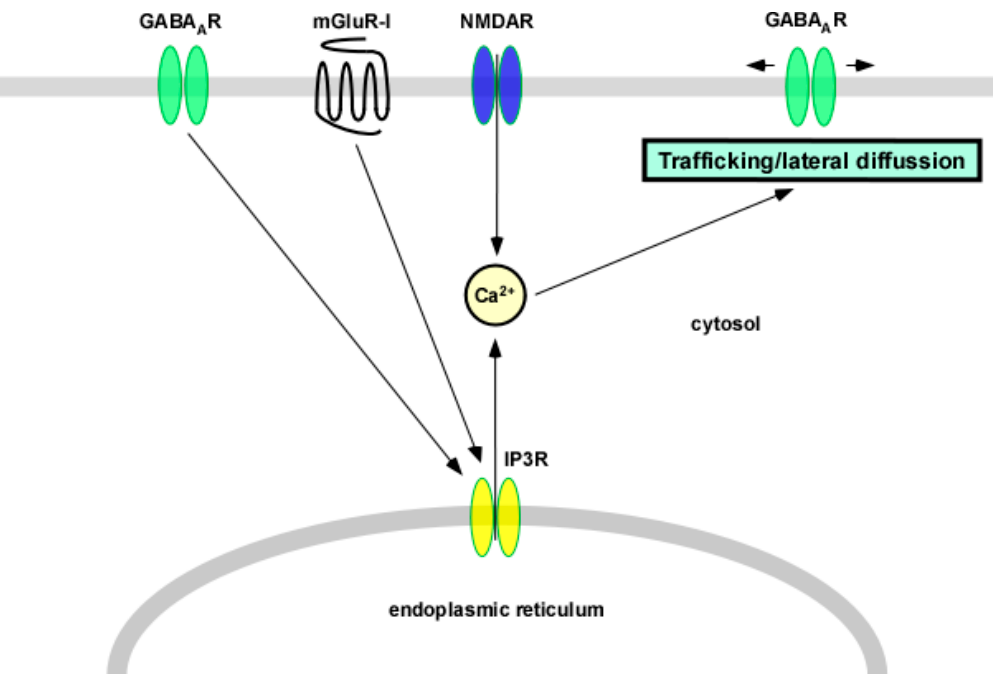
Figure 3. Regulation of GABA A receptors by intracellular calcium from different sources other than the influx through L-type VGCCs. The increase in cytosolic calcium induced by the release from intracellular stores (because of the activation of group I metabotropic glutamate receptors or the stimulation of GABA A receptors) or the influx through NMDA receptors regulates trafficking and lateral diffusion of GABA A receptors. GABA A R—GABA A receptor; mGluR-I—group I metabotropic glutamate receptors; NMDAR—NMDA receptor; IP3R—inositol trisphosphate receptor.